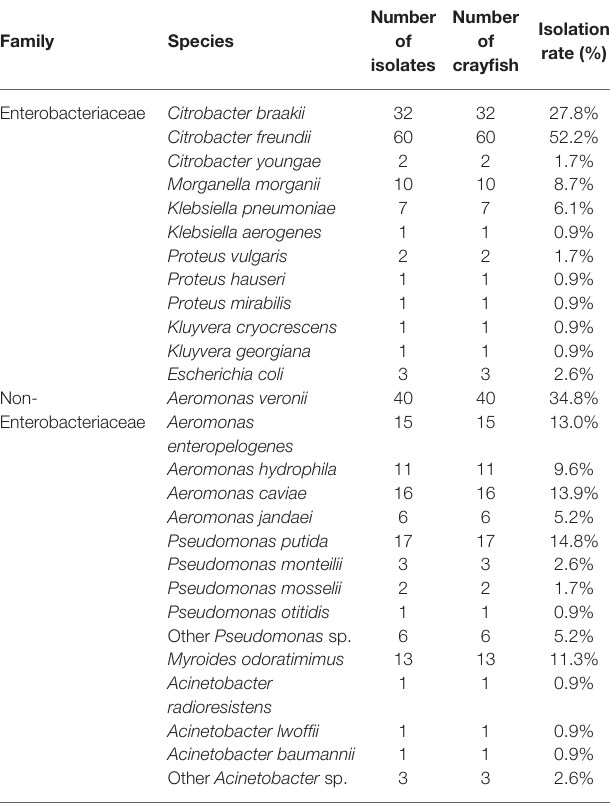
TABLE 1 | Species and number of bacteria isolated from red swamp crayfish * .